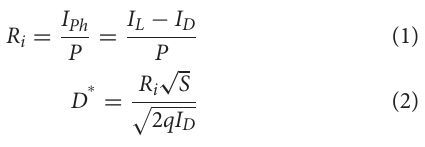
Supplementary Figure 4 . Accordingly, the largest values are 8.4 and 8.6%,